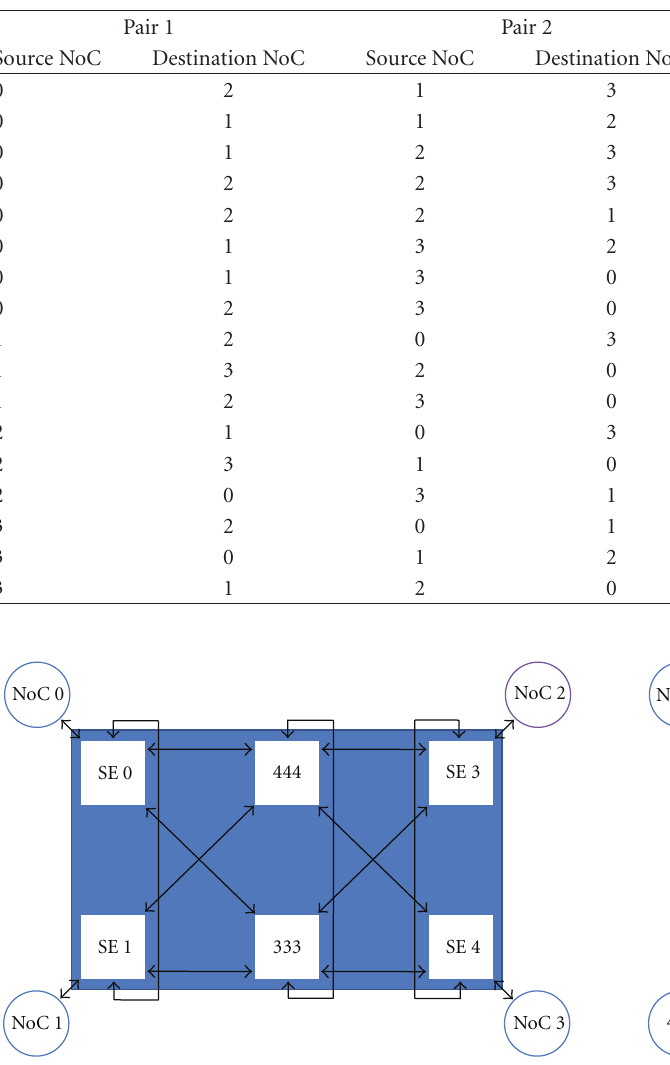
Figure 21: The simulation state of NiP-HXN model at second step of worst case.